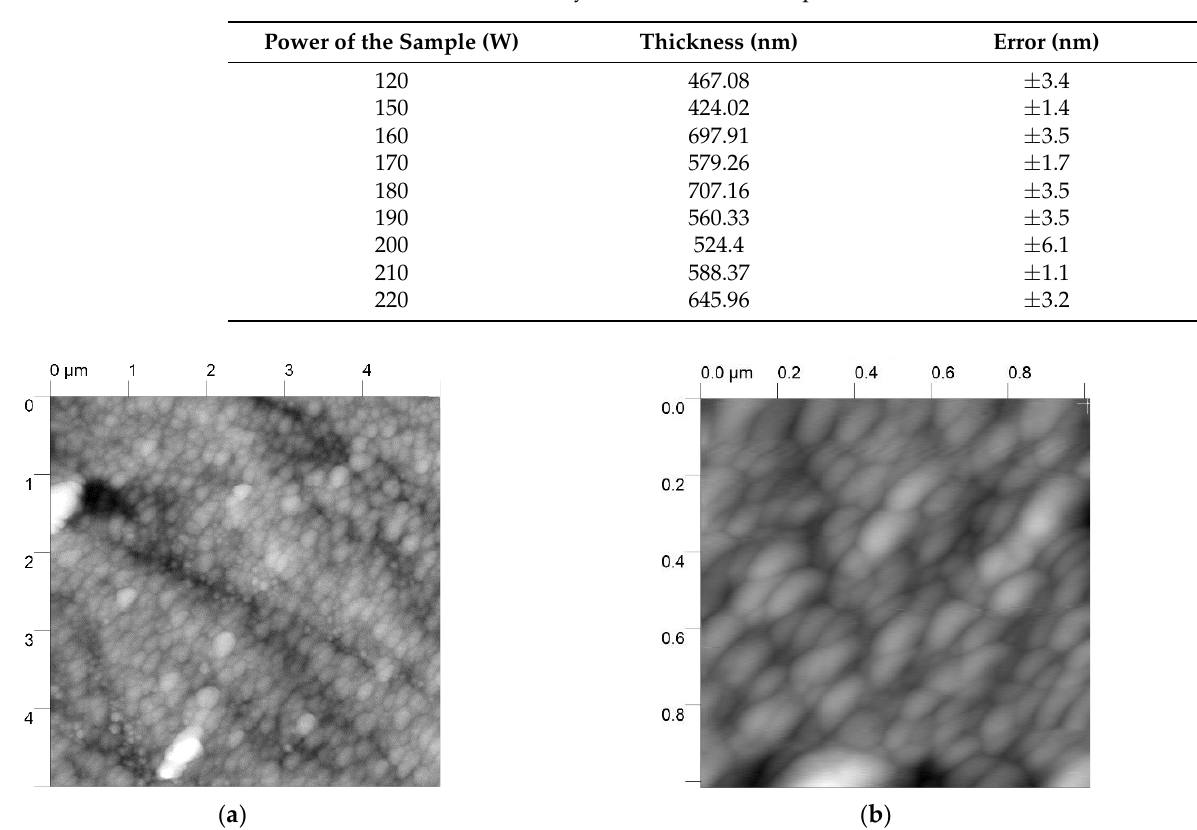
Figure 6. ( a ) Micrograph used to obtain the values of the roughness Rq (Rms) and ( b ) Micrograph used to obtain the values of average grain sizes.